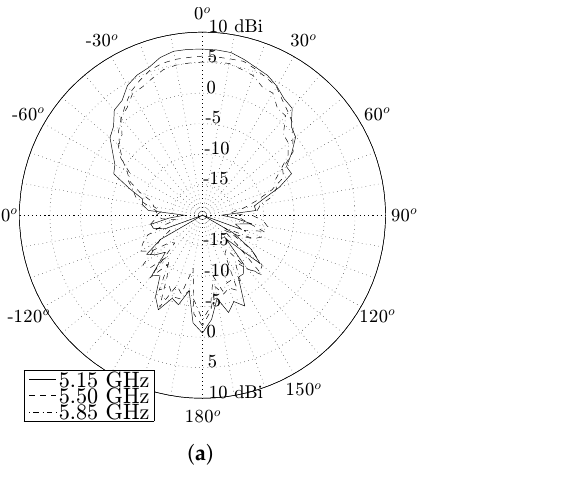
Figure 11. Free space radiation pattern of the U.FL antenna. ( a ) H-plane; ( b ) E-plane.